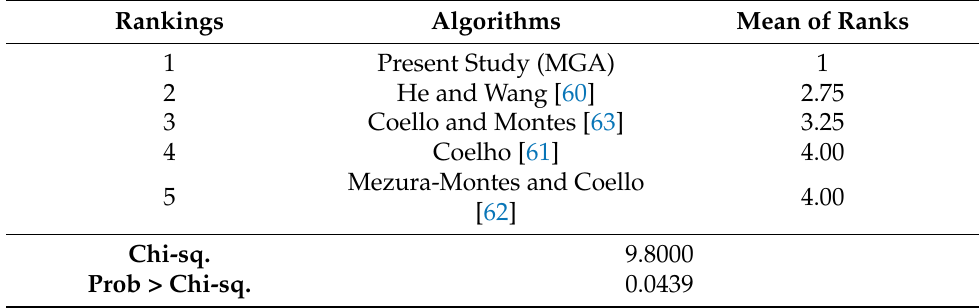
Table A6. Friedman statistical test results for the pressure vessel design problem.